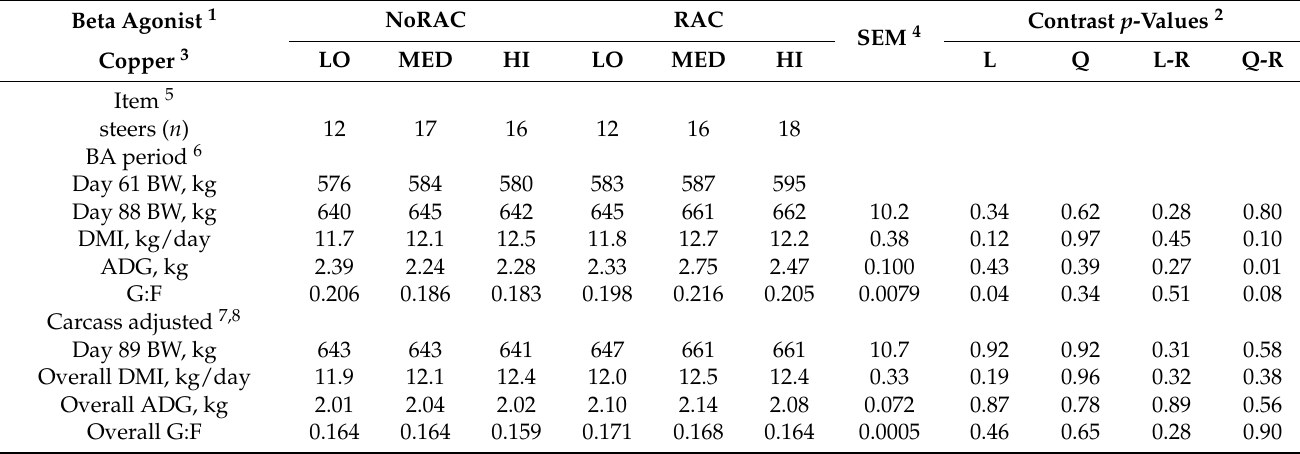
Table 4. Performance of steers fed varying copper concentrations and ractopamine hydrochloride during beta agonist period. Beta Agonist 1 NoRAC RAC